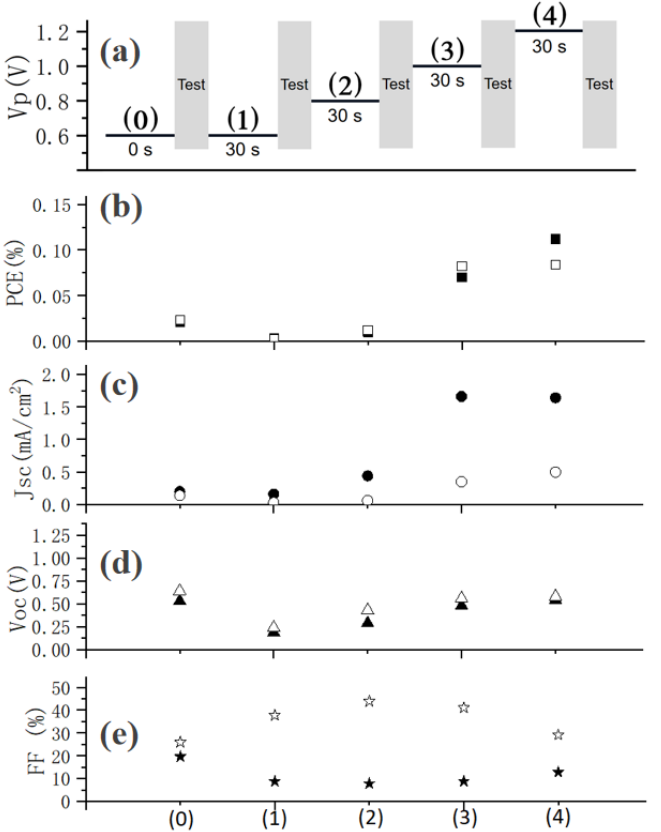
Figure 4. The performance parameters of unoptimized devices vary with the polarization conditions. ( a ) Different polarization conditions; ( b ) the variation trend of PCE with polarization conditions; ( c ) the variation trend of Jsc with polarization conditions; ( d ) variation trend of Voc with polarization conditions; and ( e ) the variation trend of FF with polarization conditions.